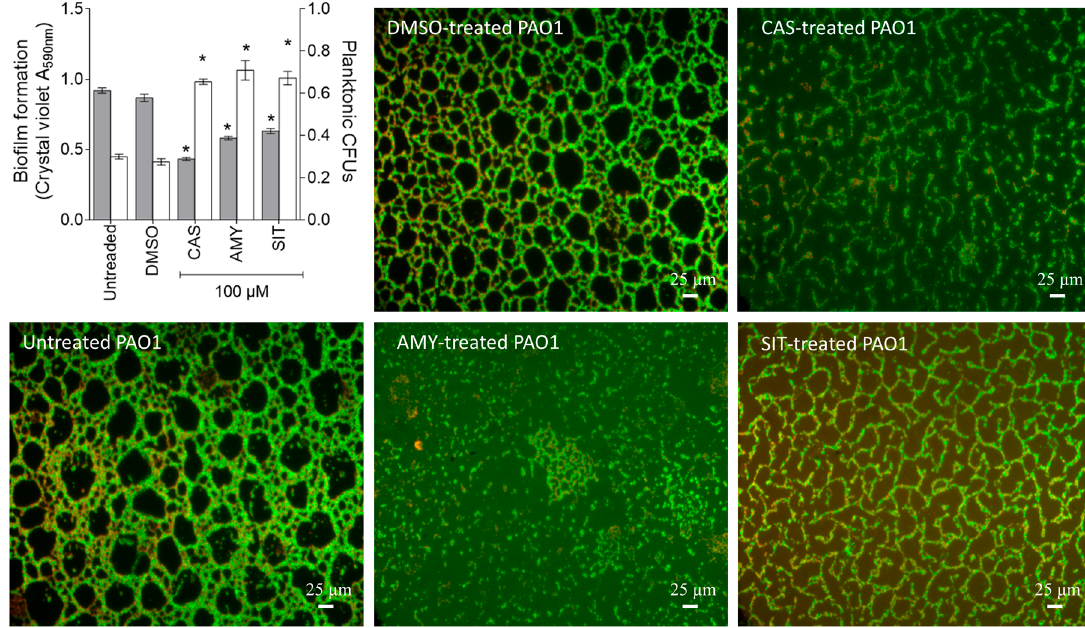
Figure 8. Effect of cassipourol, β -sitosterol and α -amyrin on a one-day-old preformed biofilm by P. aeruginosa PAO1. P. aeruginosa PAO1 cells were incubated for 24 h and then treated or not for 24 h with DMSO 1%, or cassipourol (CAS) or β -sitosterol (SIT) or α -amyrin (AMY) at 100 µM. Biofilm phenotypes were visualized as in Figure 6. Additionally, biofilm formation was quantified by crystal violet staining and measured as A 590nm and CFU measurement of planktonic bacteria and biofilm-encapsulated bacteria treated for 24 h with DMSO 1% or cassipourol (CAS) or β -sitosterol (SIT) or α -amyrin (AMY) at 100 µ M on a one-day-old culture. Quantification of biofilm formation by P. aeruginosa grown in in minimal media (grey bar) and CFU measurement (clear bar) of planktonic bacteria after static incubation at 37 ◦ C for 24 h. Biofilm formation was quantified by crystal violet staining and measured at A 590nm and planktonic bacteria by CFU measurement. Error bars represent the standard errors of the means; all experiments were performed in quintuplicate with three independent assays and asterisks indicate samples that are significantly different from the DMSO (One-way ANOVA followed by Dunnett’s test of multiple comparisons; p < 0.01).